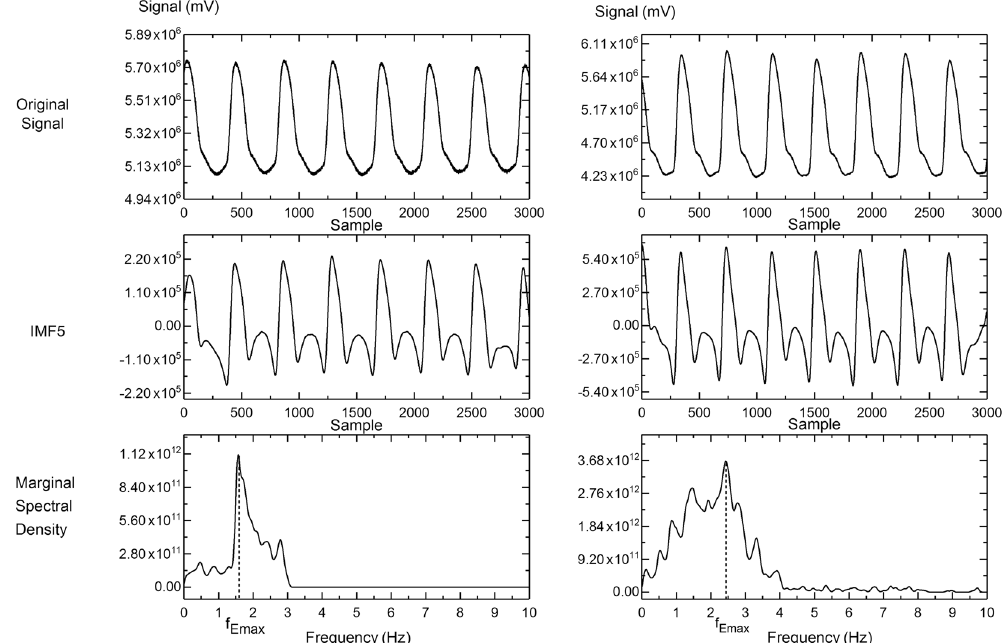
Figure 1. Representative illustration of original digital volume pulse (DVP) signals, intrinsic mode function 5 (IMF5) after ensemble empirical mode decomposition (EEMD), and marginal spectral density after Hilbert- Huang spectrum analysis from a healthy subject (left panel) and that from a diabetic patient (right panel), showing elevated instantaneous frequency corresponding to maximal energy (f Emax ) in the diabetic patient compared to the healthy